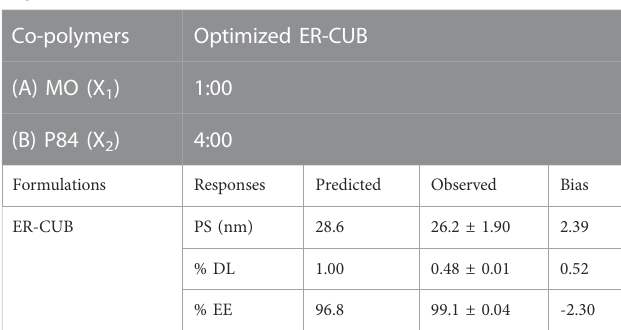
TABLE 2 Optimal formulation of copolymer proportion and validity of predicted responses data of ER-CUB.